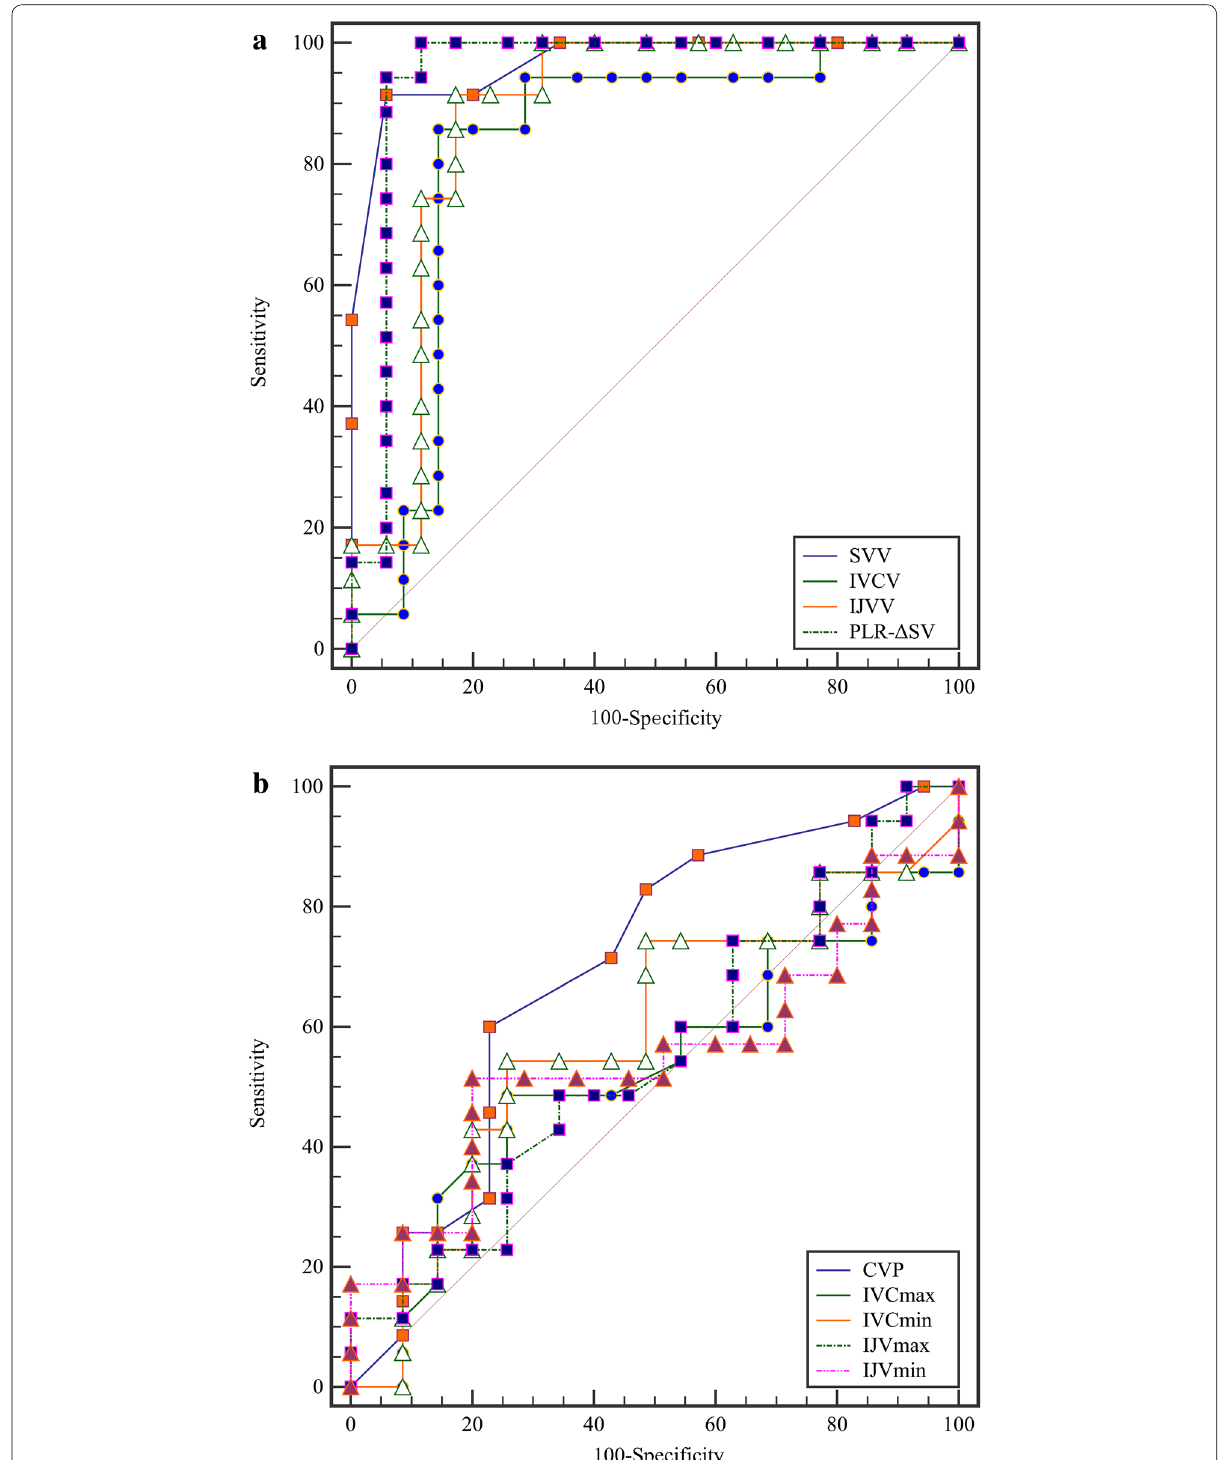
Fig. 3 Comparison of the areas under the ROC curves for the indicators used for predicting fluid responsiveness ( a , dynamic indicators; and b , static